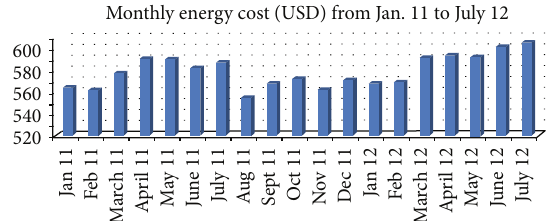
Figure 6: Estimation costs curve for monthly energy consumption, Missinguileo site from January 11 to July 12.